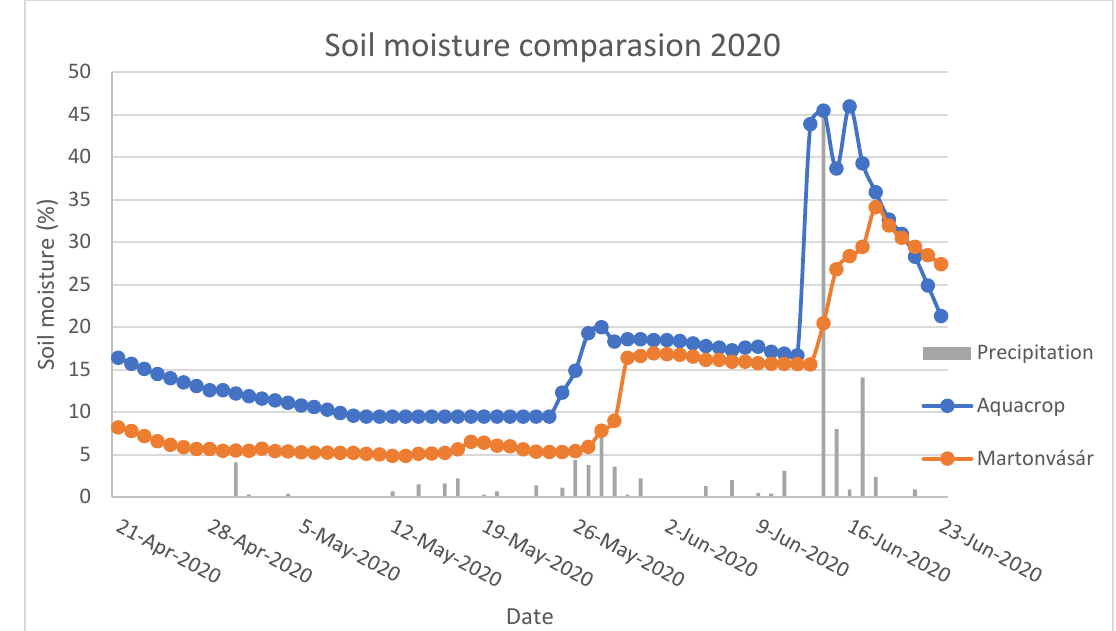
Figure 10. Comparison between modeled and measured soil moisture in Martonvásar for 2020.